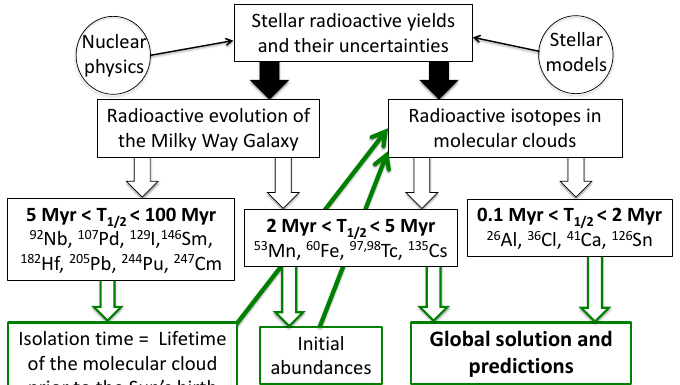
Figure 1. Flowchart of the RADIOSTAR project. From top: stellar models and nuclear physics are used as input for calculating the stellar yields of SLR nuclei. These, in turn, serve as input for investigating the evolution of the SLR abundances in the Milky Way Galaxy and in molecular clouds. In first approximation, the half-life of each SLR nucleus (third row) determines if its abundance in the ESS was predominately contributed by stars in the Galaxy (over longer timescales), in molecular cloud (over shorter timescales), or in both. The abundances of the SLR nuclei with relatively long half lives (third row, left box) have a predominant galactic contribution. They can be used to determine the initial composition of the molecular cloud where the Sun was born and the timescale of such birth. This information can be fed (green arrows) into the analysis of the cloud